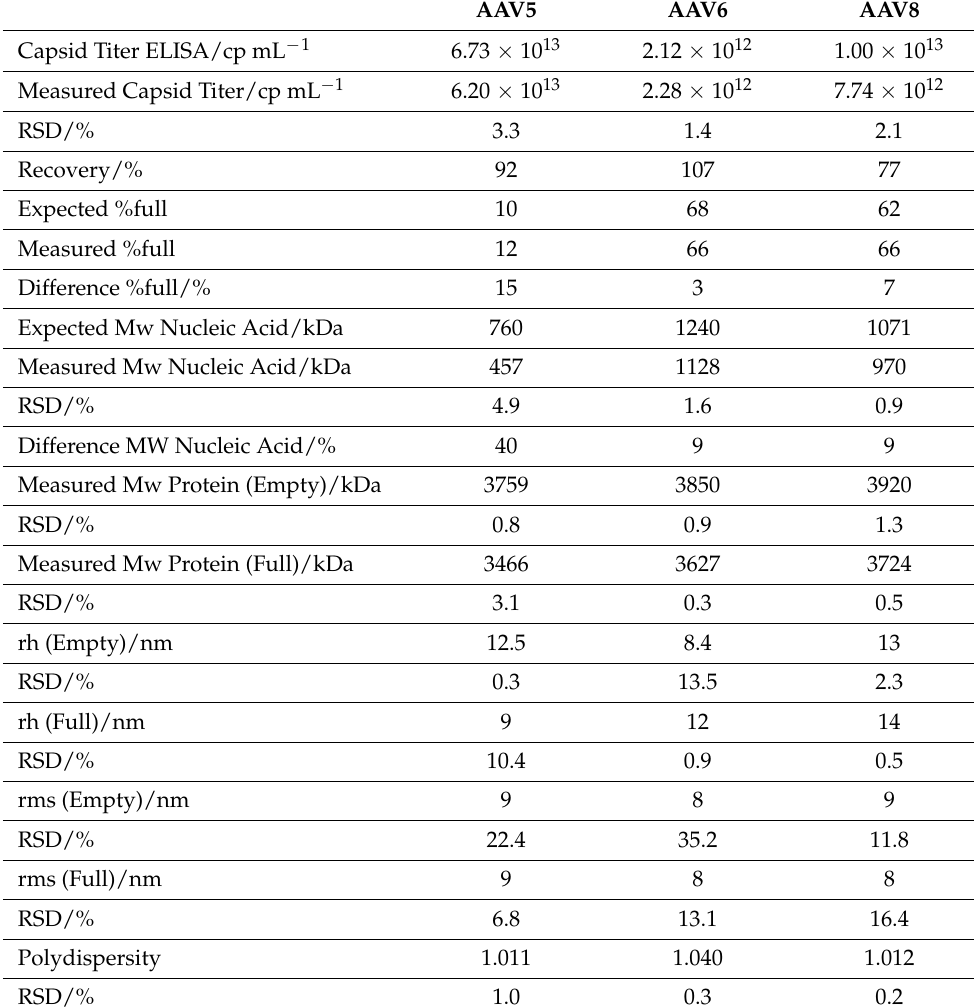
Table 2. Overview of IEC-MALS method performance results of empty and filled AAV8 capsids of different